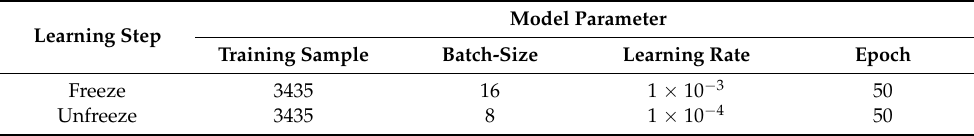
Table 2. Parameters for model training.